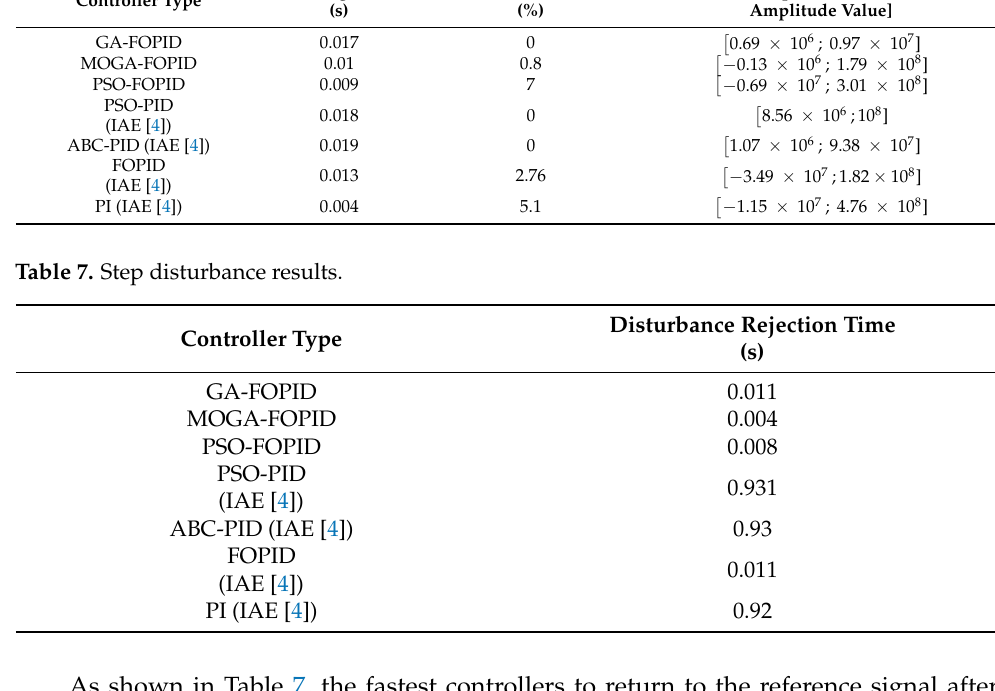
Figure 9. The speed response of the wind turbine model for a wind gust reference.